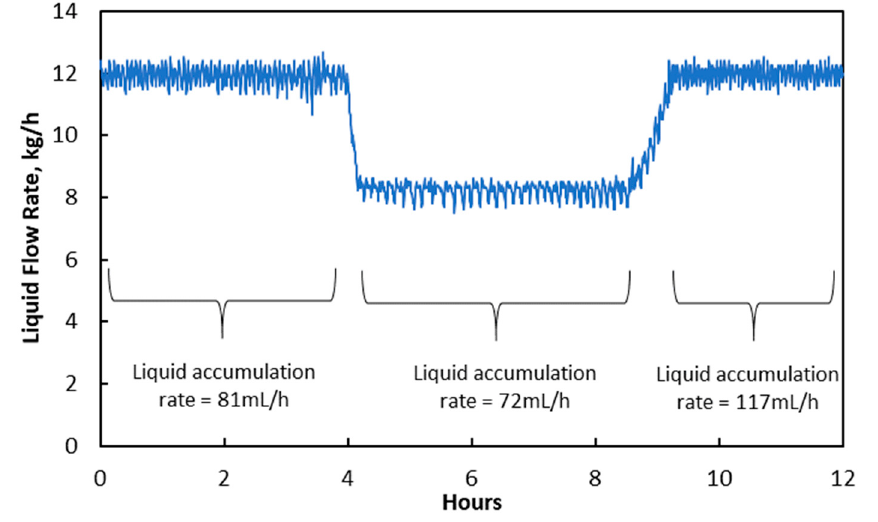
Figure 5. Changes in liquid flow rate and its impact on liquid accumulation rate at treated gas knock-out drum. Table 6. Changes in the degree of membrane wetting when the liquid flow rate was adjusted.